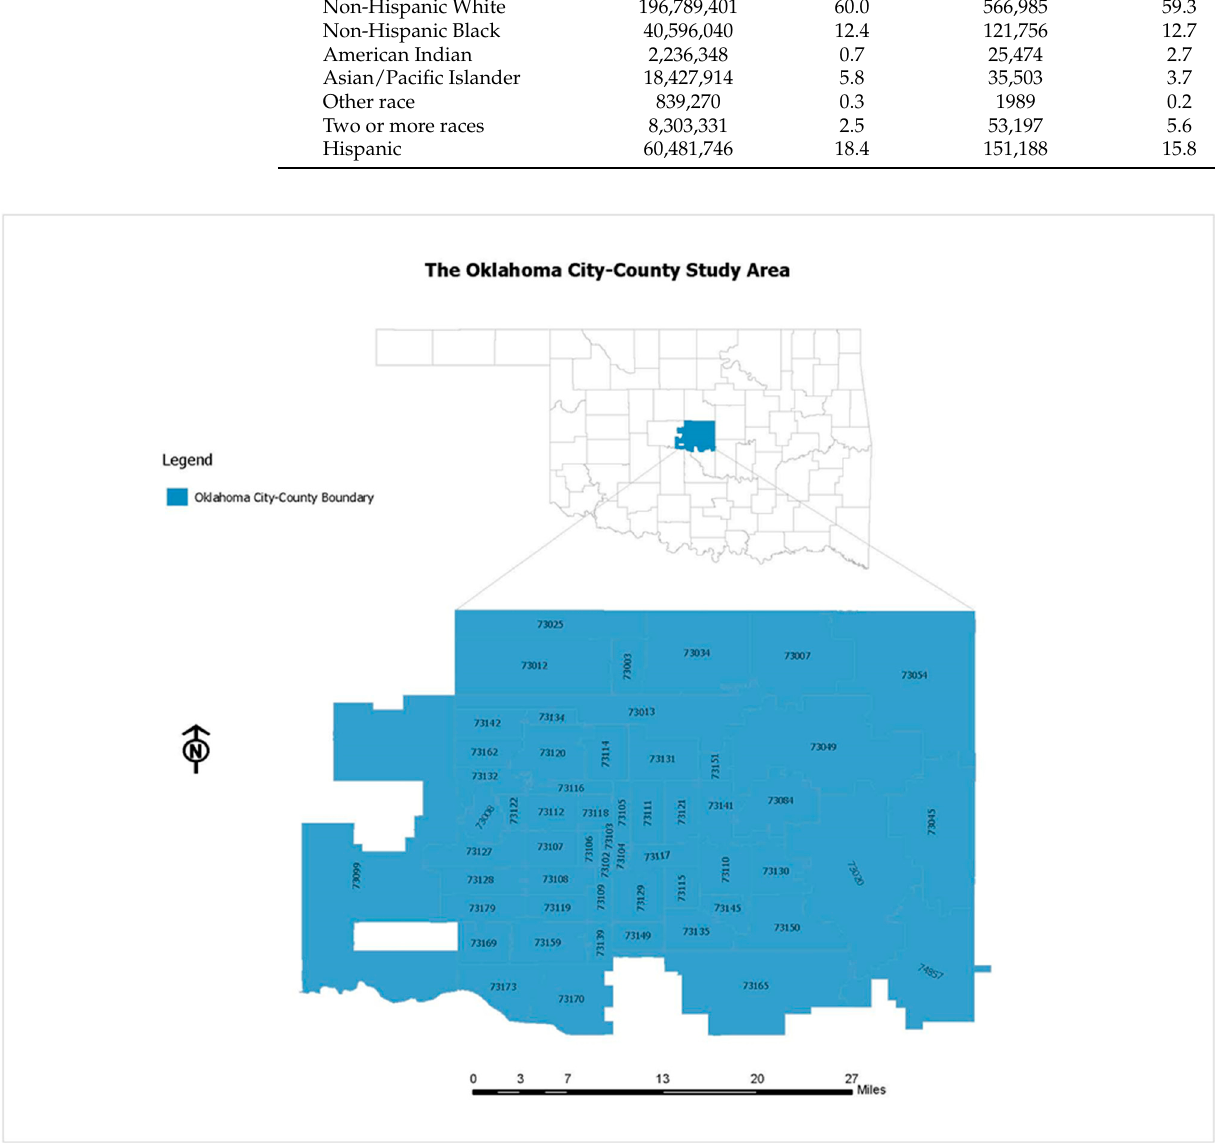
Figure A1. The study area of Oklahoma City–County with ZIP code boundaries.